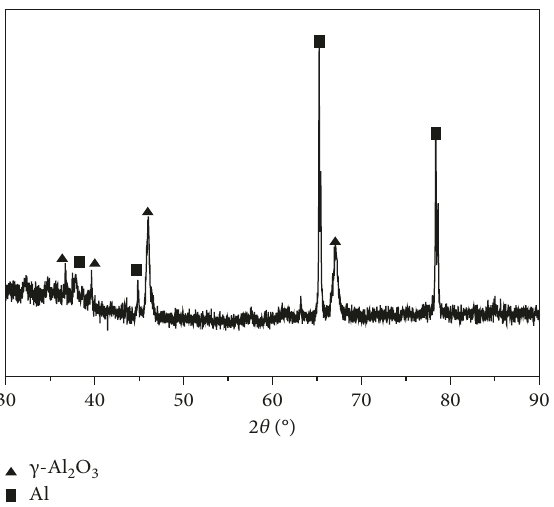
Figure 2: The XRD pattern of the as-prepared MAO sample.